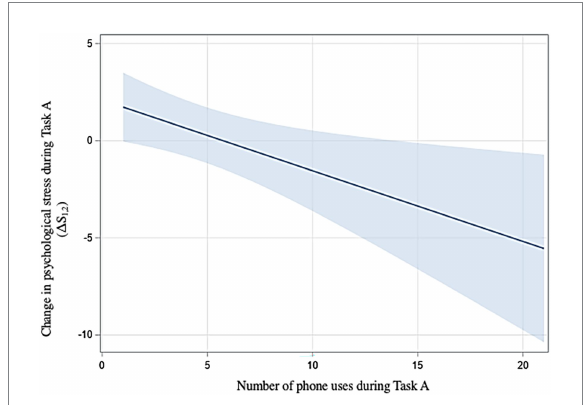
FIGURE 4 Relationship between number of phone uses and psychological stress (H2a) with 95% confidence interval.